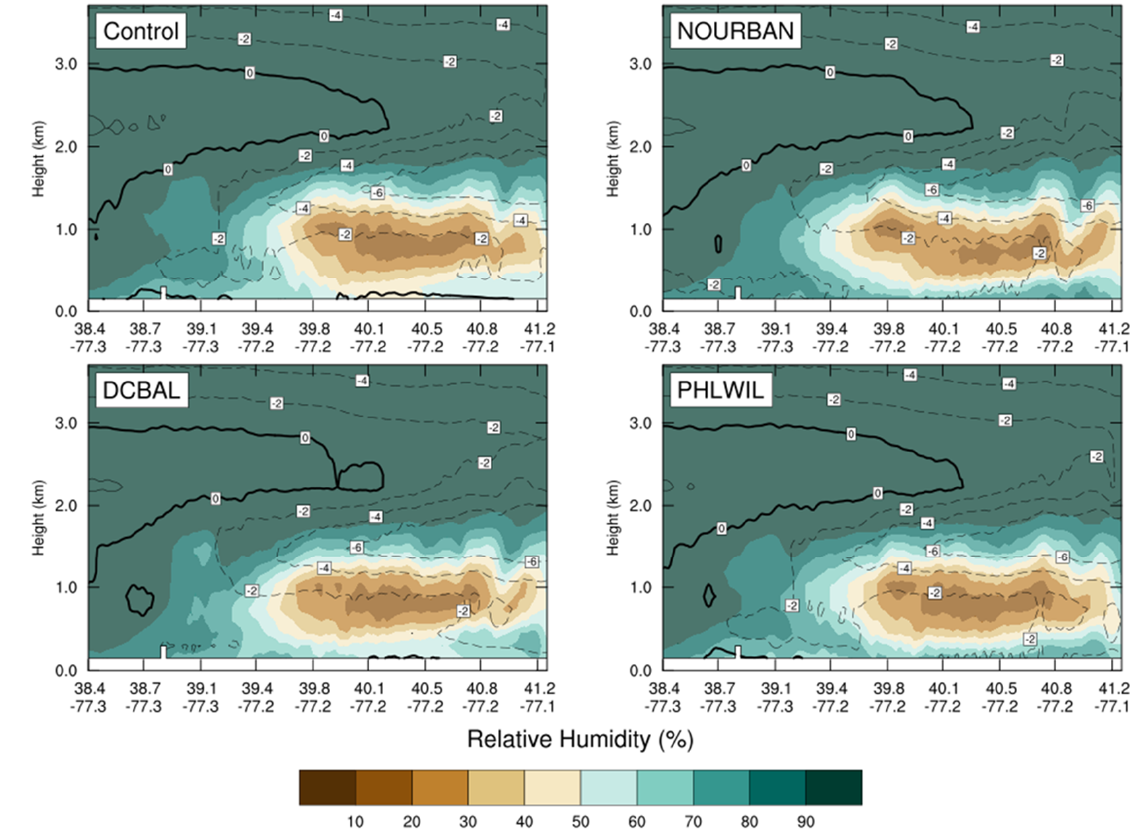
Figure 12. Vertical cross-section of WRF-simulated relative humidity (%) and air temperature, T, (°C) from southwest to northeast beginning in Northern Virginia and ending near Princeton, New Jersey. Dashed (solid) lines denote T < 0 °C (T > 0 °C); thick, black line denotes T = 0 °C. Valid at 0800 UTC on 6 February 2004.